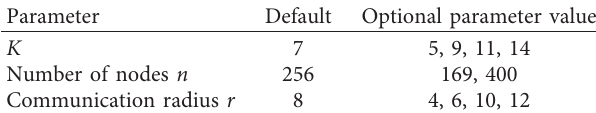
Table 2: Range and default values of parameters.